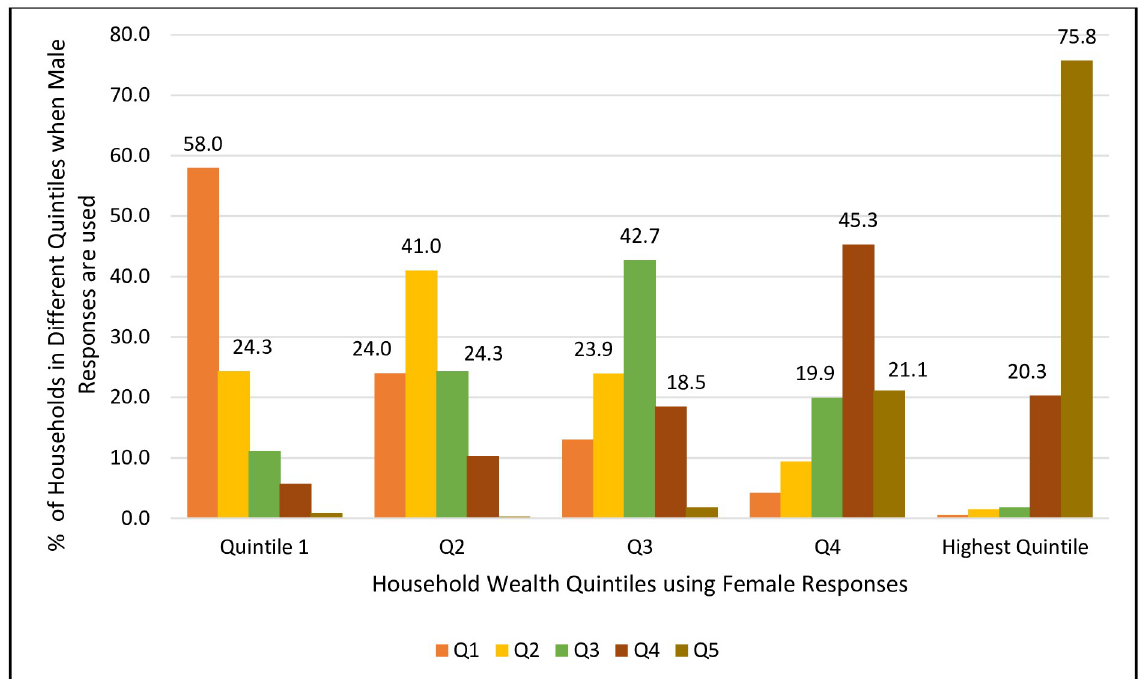
Fig 1. Distribution of households within each female response-based quintile when male responses are used for asset-score quintile classification.